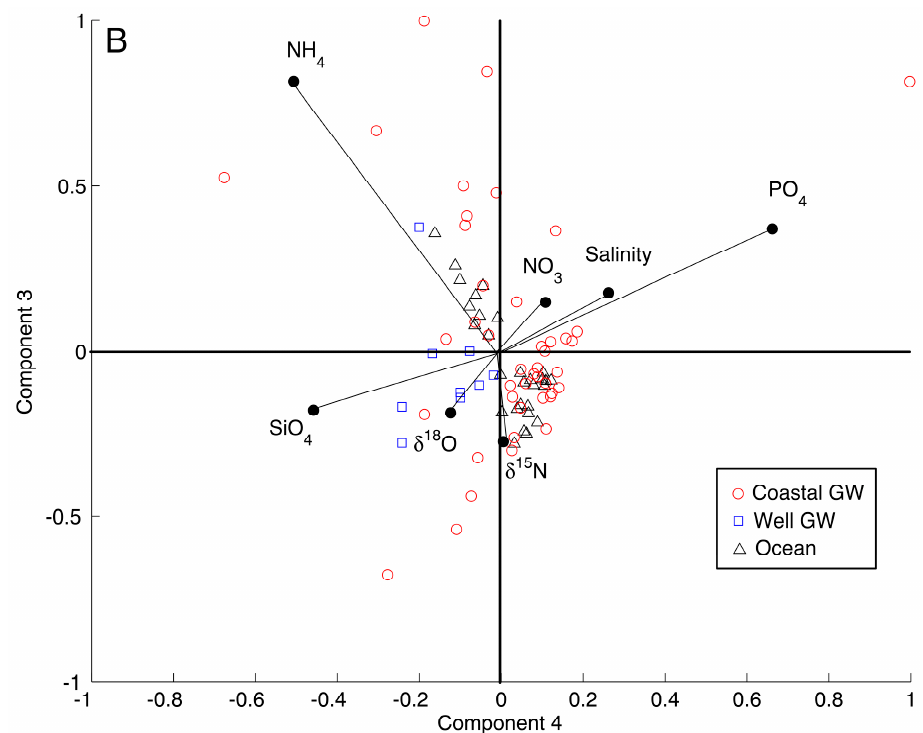
Figure 5. Results of the Principal Component Analysis (PCA). Components 1 and 2 ( A ) and 3 and 4 ( B ) accounted for 39%, 19%, 14%, and 12%, of the variability respectively. Coefficient vectors represent how much each parameter (salinity, nutrient concentrations, etc.) contributed to the component, with the longer vectors contributing more than the shorter vectors.